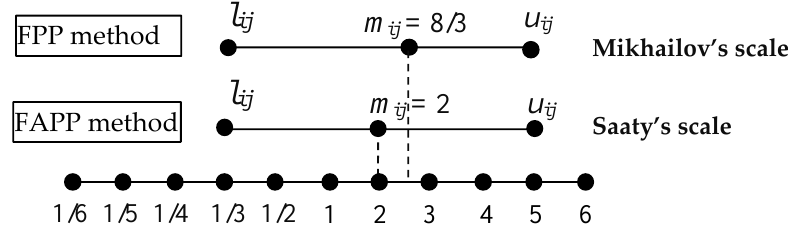
Figure 3. Mikhailov’s scale and Saaty’s scale .